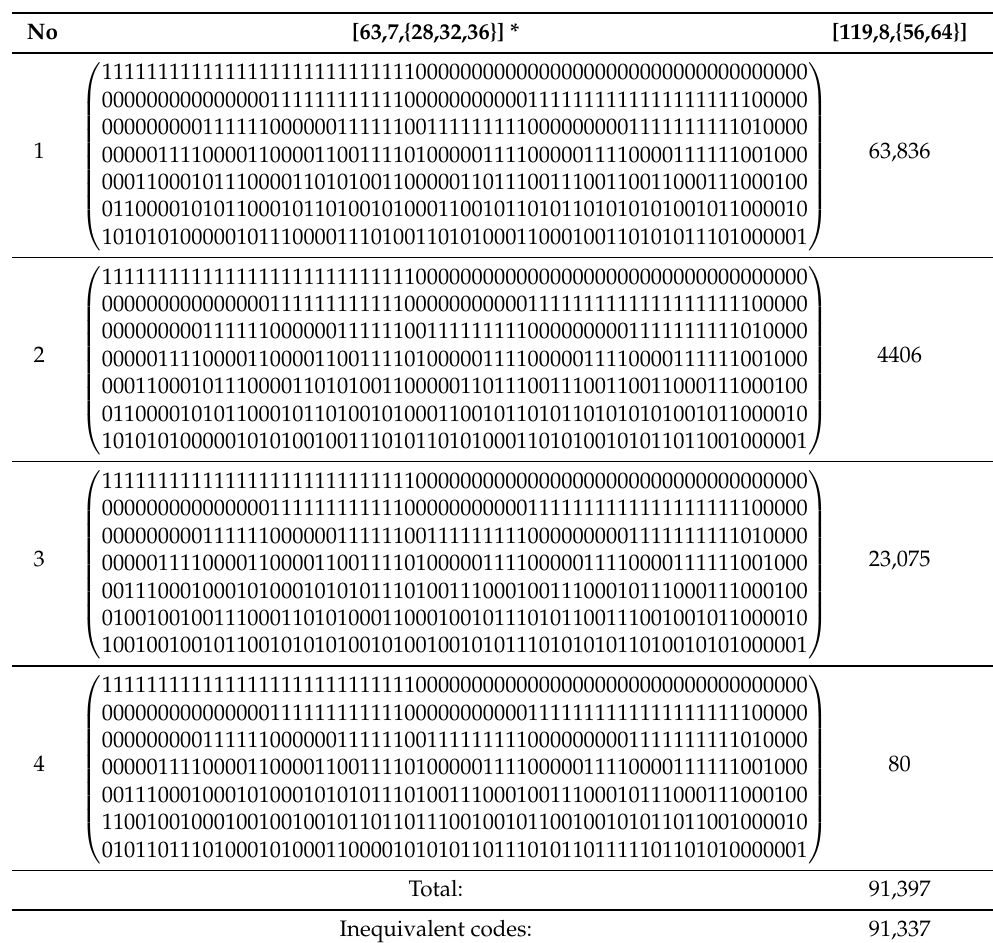
Table 3. The [119,8,{56,64}] codes constructed using